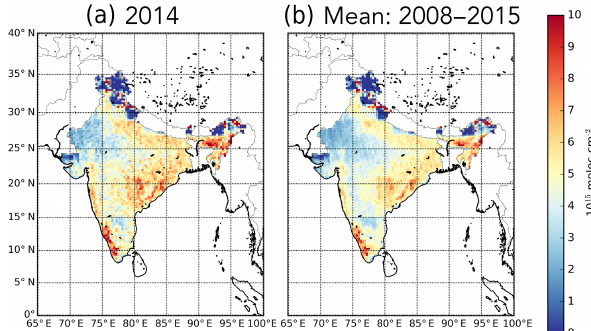
Figure 8. Annual mean OMI HCHO slant columns (10 15 moleccm − 2 ) over India for (a) 2014 and (b) 2008–2015, averaged on a common 0 . 25 ◦ × 0 . 3125 ◦